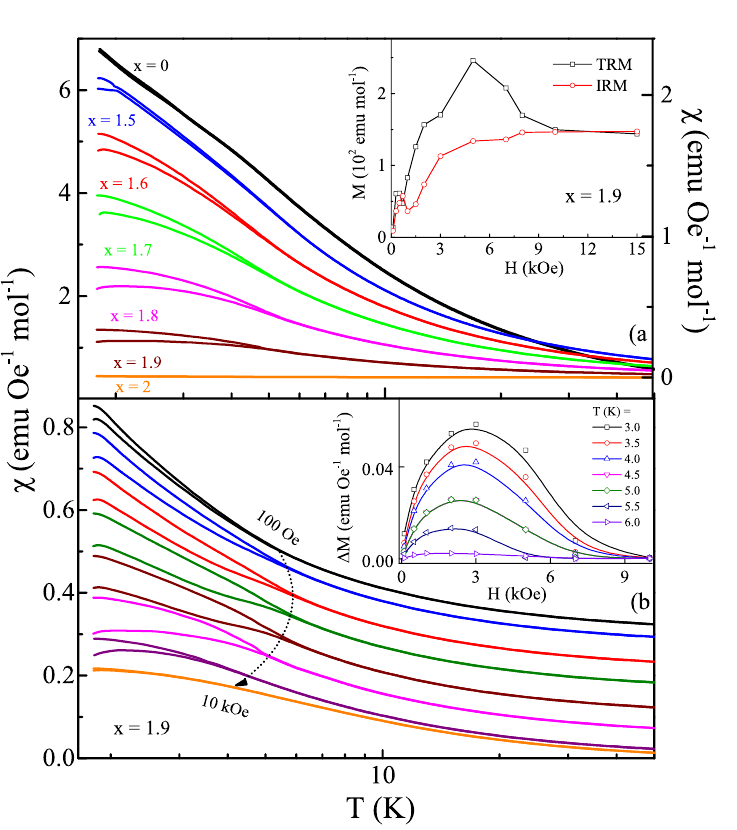
Figure 3. ( a ) Dc magnetic susceptibility χ dc (ZFC and FC) versus T at H = 100 Oe for Dy 2 − x La x Zr 2 O 7 (0 ≤ x ≤ 2). Inset: Thermo and isothermo remnant magnetization as a function of field at T = 1.8 K for Dy 0.1 La 1.9 Zr 2 O 7 . ( b ) Dc magnetic susceptibility χ dc (ZFC and FC) versus T at various dc applied field for Dy 0.1 La 1.9 Zr 2 O 7 (data is shifted along y-axis for better visibility of T irr ). Inset: Field response of (cid:31) M = M FC – M ZFC of Dy 0.1 La 1.9 Zr 2 O 7 at various